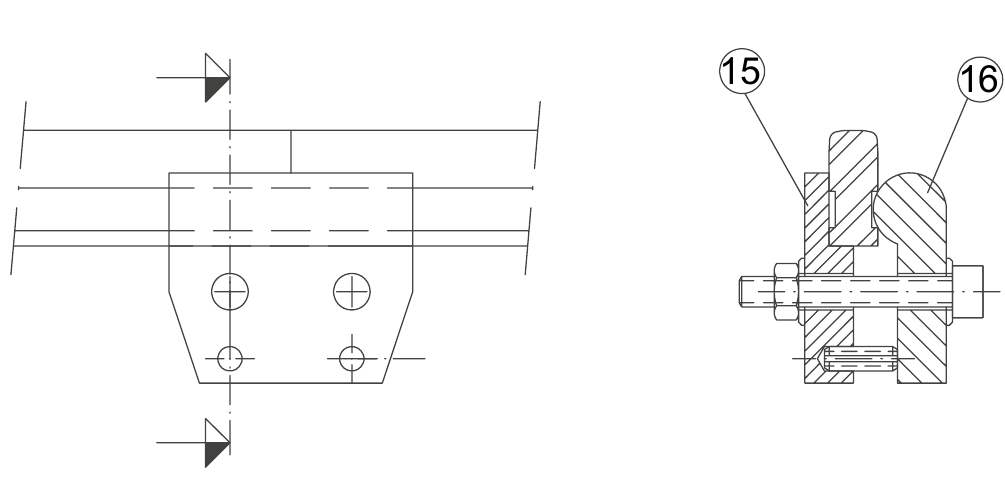
Figure 7. Cross-section of the rail to rail